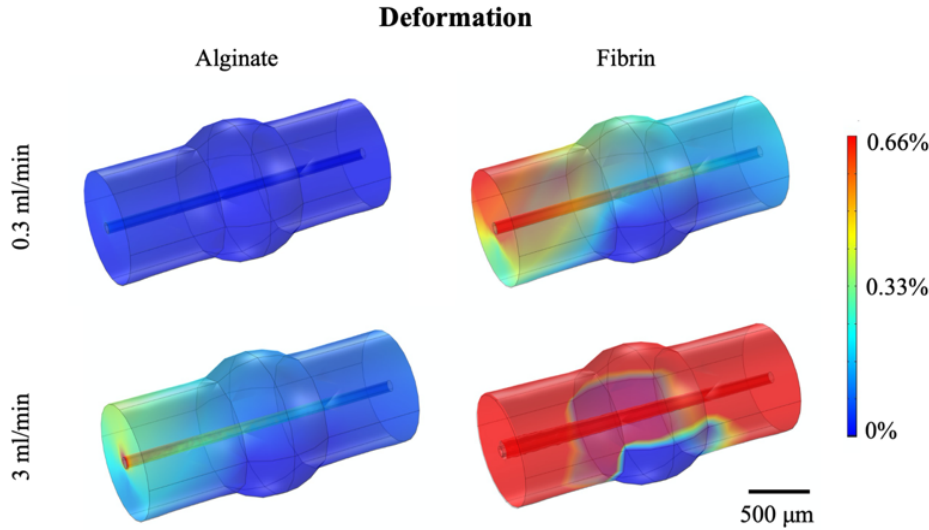
Figure 2. Channel displacement within alginate and fibrin models evaluated at minimum flow rate (0.3 mL / min) and maximum flow rate (3 mL /